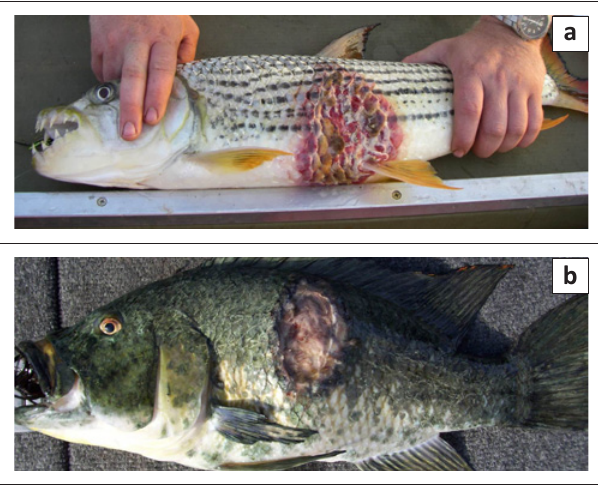
FIGURE 4: (a) Aphanomyces invadans hyphae in necrotic muscle tissue of Labeo lunatus from the Chobe River. Note granulomatous tracts surrounding the hyphae (arrow). Grocott’s silver stain. (b) Deeply penetrating Aphanomyces invadans hyphae (arrow) within granulomatous tracts in the kidney of Labeo lunatus from the Chobe River. Grocott’s silver stain.